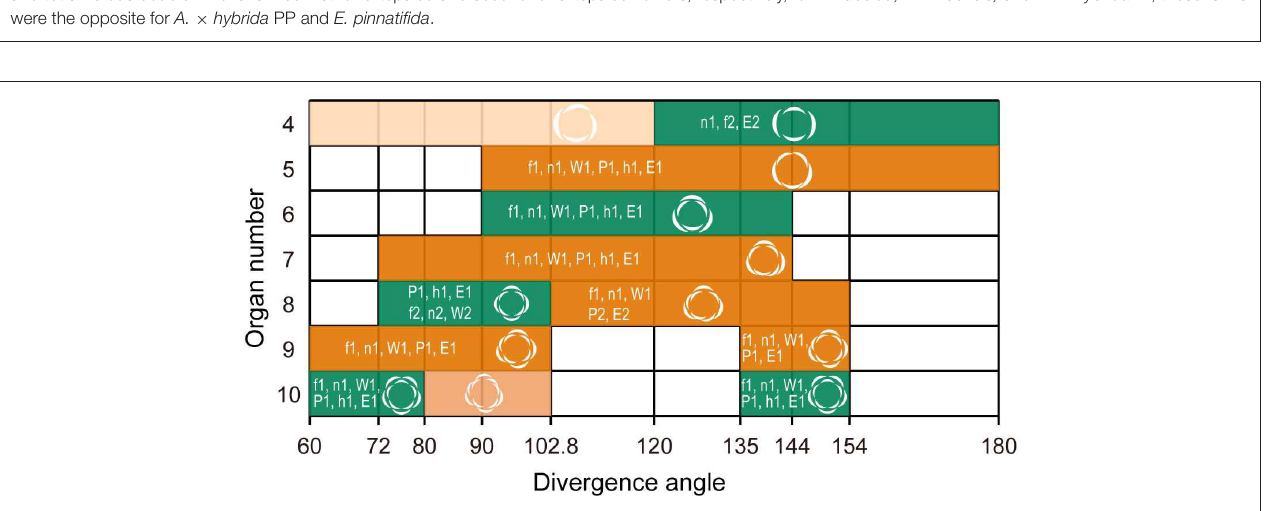
FIGURE 3 | Double-whorls of trimery, tetramery, and pentamery can develop from spiral phyllotaxis at different divergence angles. Aestivation patterns derived from calculations using the spiral phyllotaxis model with a constant divergence angle (degree; horizontal axis) in relation to tepal number (vertical axis). Whorled and spiral flowers observed in Anemone and Eranthis species are shown in green and orange, respectively; their relative frequency is above 50% in some species or forms, except for the light-colored aestivations (EAAI, 4% maximum; EAIEAIEIEI, 11% maximum). Codes f1, n1, W1, P1, h1, and E1 indicate the most frequent aestivations in A. flaccida , A. nikoensis , A. × hybrida W, A. × hybrida PP, A. hepatica , and E. pinnatifida , respectively. For the 4-tepaled and 8-tepaled flowers, the second most frequent aestivations are also indicated as f2, n2, W2, P2, and E2, where letters indicate the same species as in the most frequent aestivations. Aestivations in white regions are hardly observed in nature (i.e., < 3% of the relative frequency in all the species and forms we examined; see Supplementary Table 1